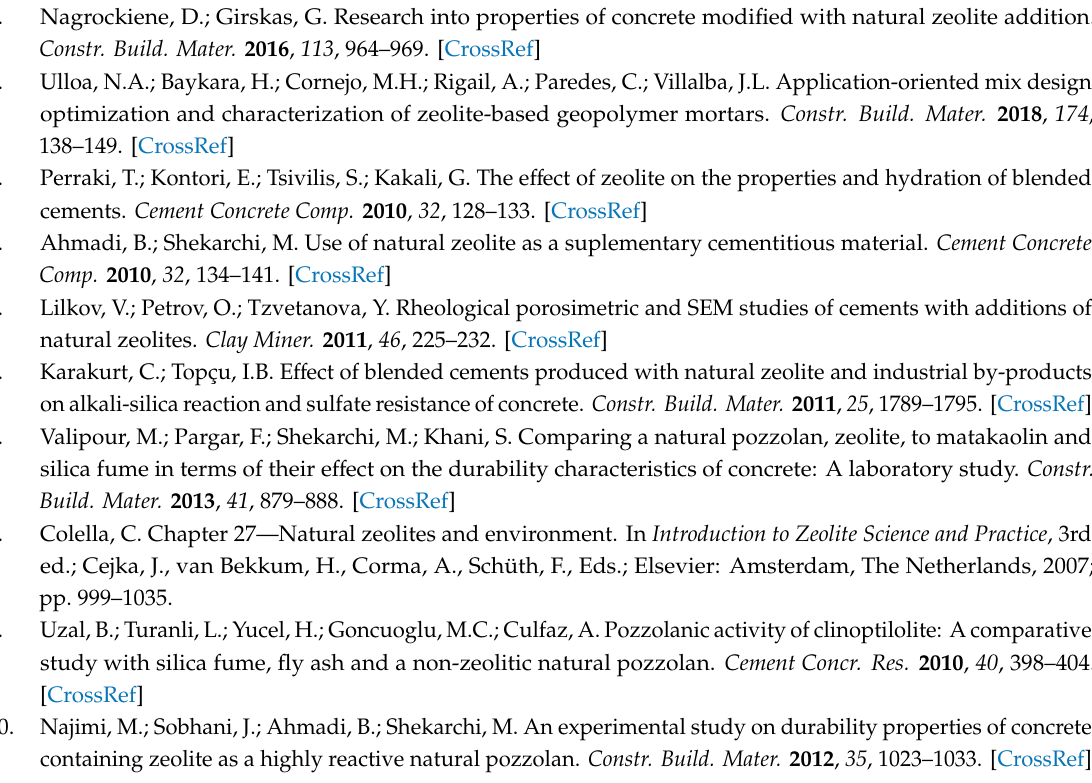
Supplementary Materials: Figure S1: Images of (a) grinding to < 3 cm (b) grinding to < 1 cm and (c) milling